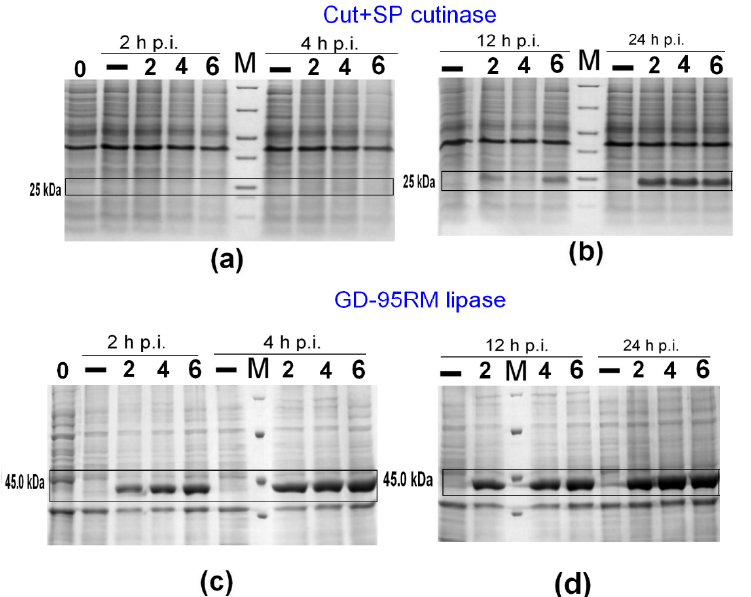
Figure 1. The expression of recombinant Cut+SP cutinase ( a , b ) and GD-95RM lipase ( c , d ) using lactose as an inducer. M—Pierce™ Unstained Protein MW Marker; 2/4/6—concentration of lactose as an inducer (mM); 0—time point when E. coli BL21 (DE3) has been subjected for induction; —–control sample of recombinant E. coli BL21 (DE3) cells growing without induction; p.i.—post-induction time in hours. The target enzymes are marked with black boxes. Tricine-SDS-PAGE was used for Cut+SP analysis and glycine-SDS-PAGE for GD-95RM,